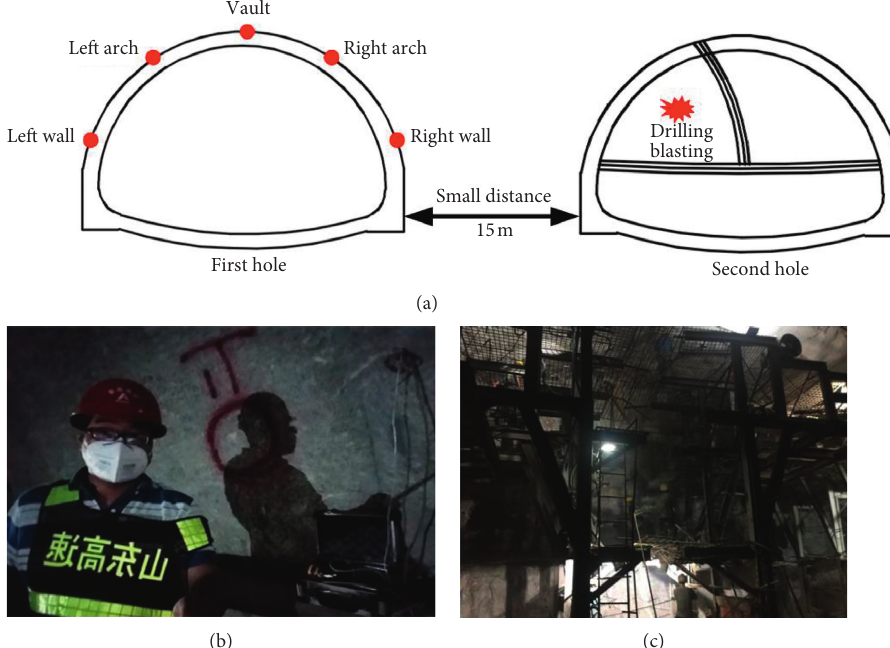
Figure 2: Daling tunnel vibration speed measurement points and on-site operation. (a) Location of the vibration measurement point. (b) Sensor installation. (c) Drilling and blasting operation.